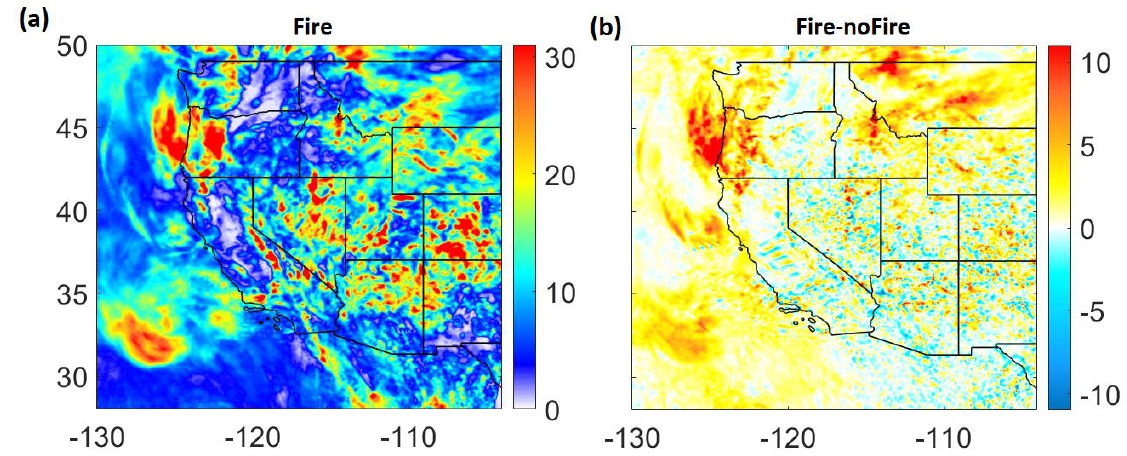
Figure 11. Spatial distribution of average ( a ) cloud optical depth from ‘Fire’ simulation, and ( b ) difference between the ‘Fire’ and ‘noFire’ simulations for the first half of September 2017.